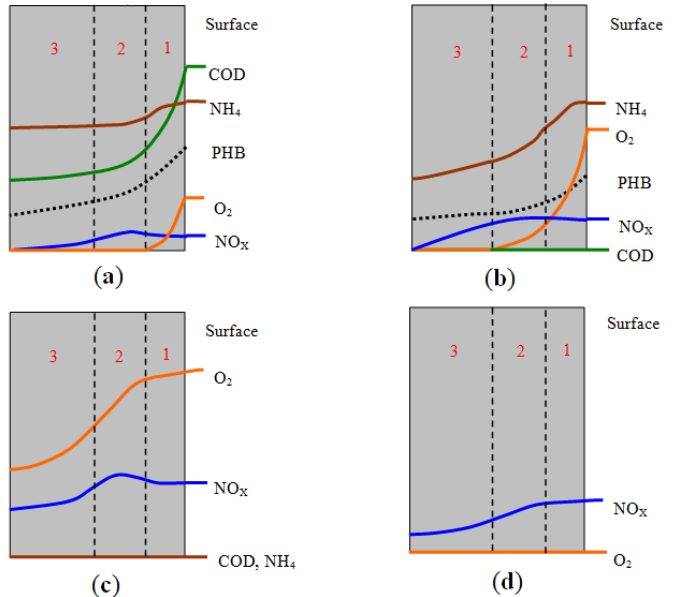
Figure 8. Schematic profiles of substances transfer inside the granule. ( a ) Beginning of aeration; ( b ) Carbon deficit; ( c ) Ammonia deficit; ( d ) Idle period. Curves represent variation of substances concentration in different